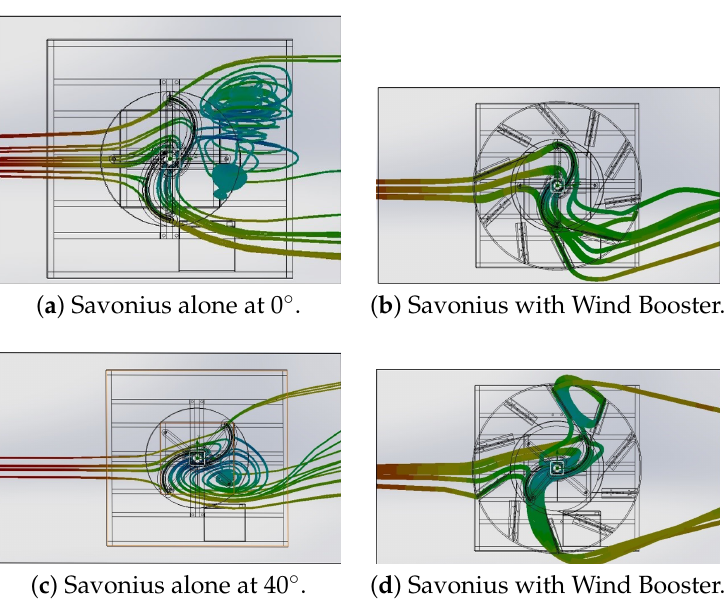
Figure 12. Wind Flow behavior at 2.04